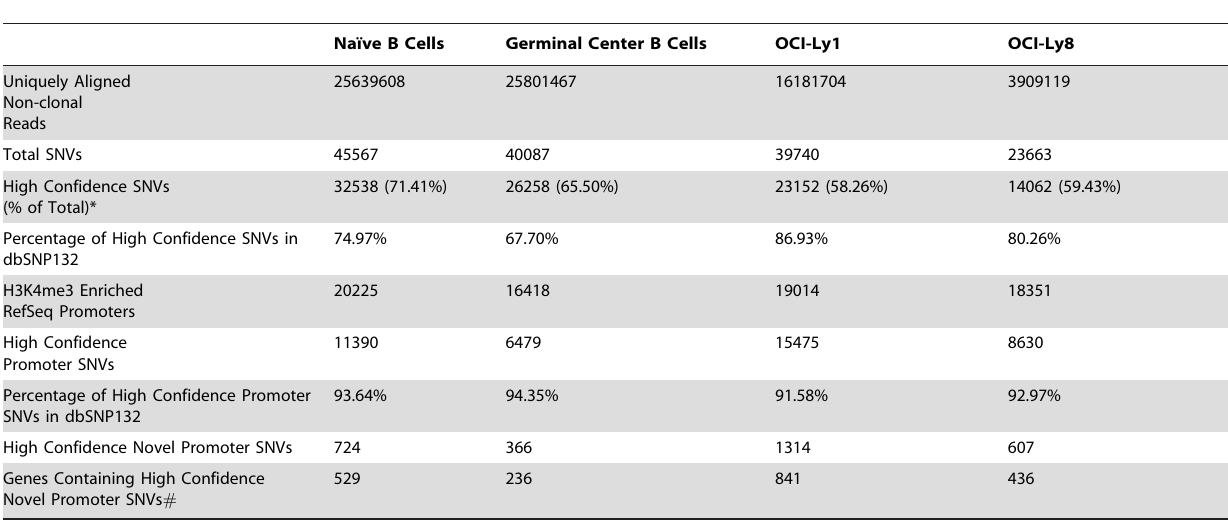
Table 1. H3K4me3 ChIP-seq and SNV detection information of NB, GCB, OCI-Ly1, and OCI-Ly8 cells.